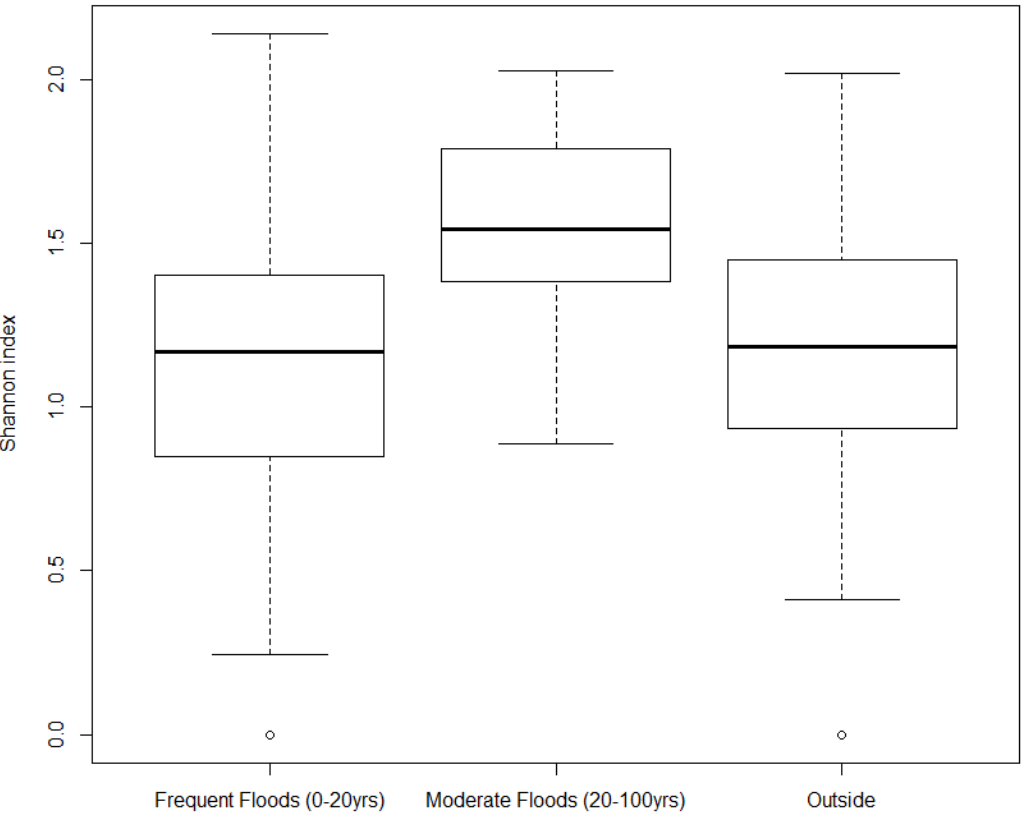
Figure 6. Graph of Shannon index of tree diversity based on the three different zones (Flood recurrence interval of 0–20 years; Flood recurrence interval of 20–100 yrs; Outside the